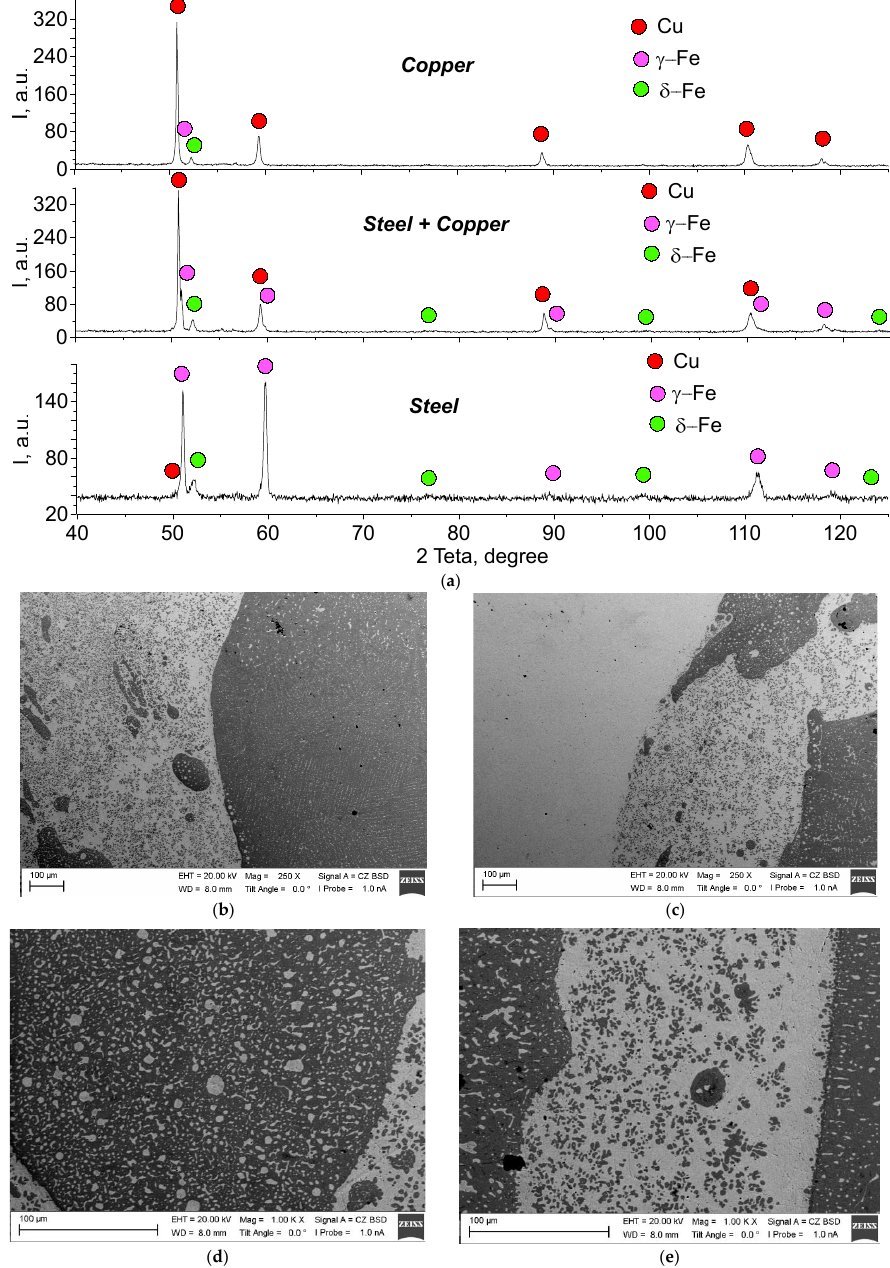
Figure 4. The XRD patterns of “copper-steel” sample ( a ). SEM BSE images of boundaries between copper (light areas) and steel (dark areas) layers in “copper-steel” samples produced by electron beam additive manufacturing ( b – e ). Figure 5 gives the “stress - strain” curve for polymetallic sample of the “ copper- steel ” system from which the procedures for calculating the localization of deformation by the DIC method were carried out, presented in “ 3.3. Digital image correlation ” . It can be seen from the curve that the ultimate tensile strength (UTS) of the “ copper- steel ” system is 299 183 M P a = MPa, elastic limit σ E = 150 MPa, yield strength 0 . 2